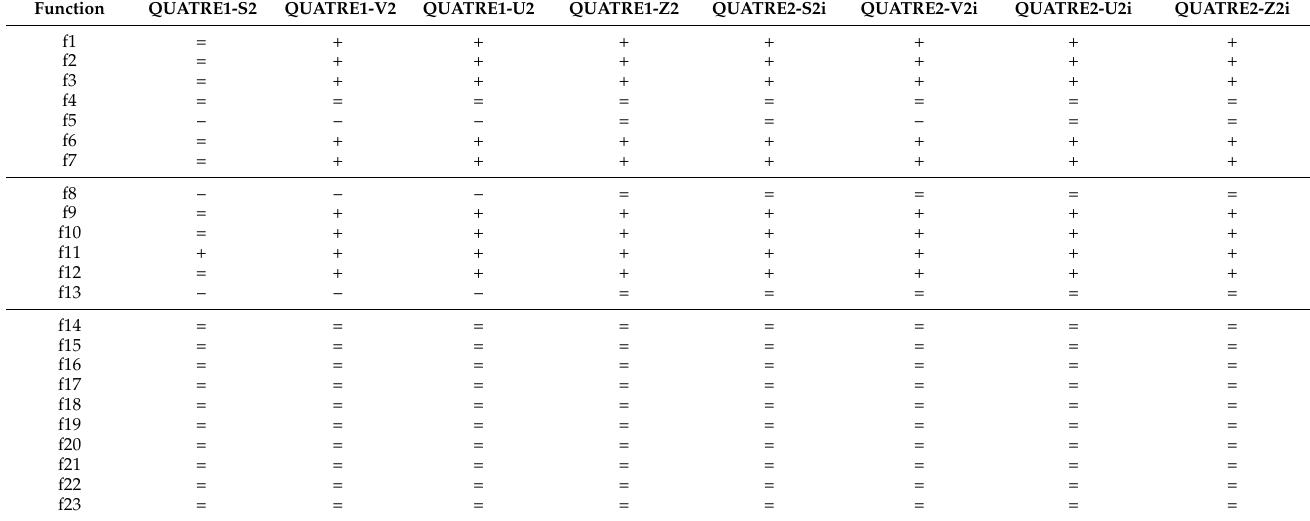
Table 16. The t-test results of the compared algorithms (QUATRE1-S2, QUATRE1-V2, QUATRE1-U2, QUATRE1-Z2, QUATRE2-S2i, QUATRE2-V2i, QUATRE2-U2i, and QUATRE2-Z2i) on BDE. Function